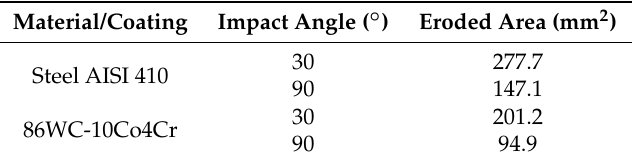
Table 6. Eroded area as a function of the impact angle for both martensitic stainless steel (AISI 410) and tungsten carbide (86WC-10Co-4Cr)